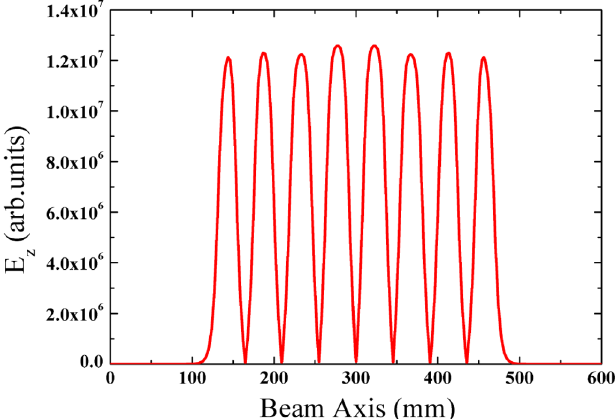
FIG. 18. The electric field distribution on axis after tuning.